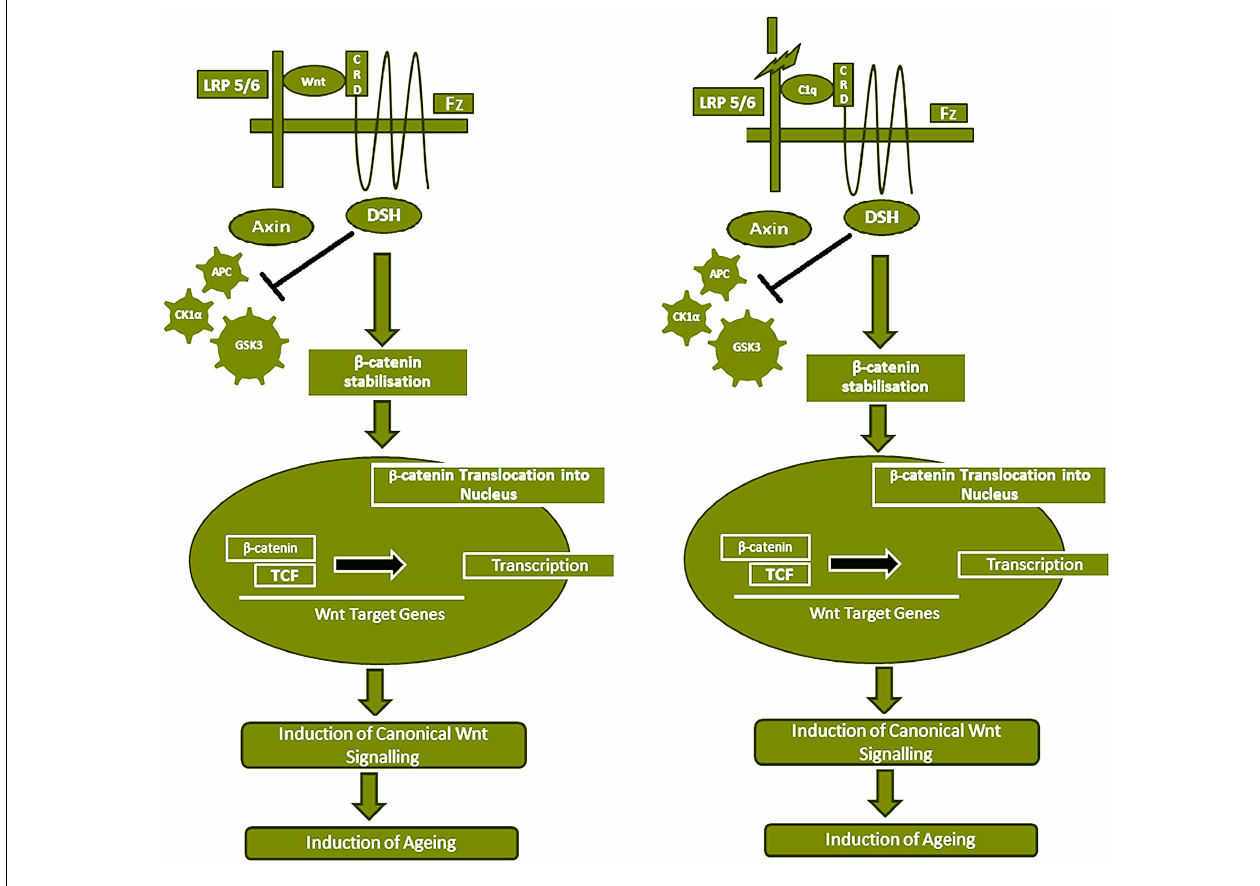
activated, which has been shown to induce aging. C1q concentration in the serum increases with age. C1q competes with 200-fold higher binding affinity with Wnt for Fz receptor and stimulates C1s-dependent cleavage of the ectodomain of LRP6. The C1q binding to Fz receptor also blocks the β -catenin destruction complex (APC, PP2A, GSK3, and CK1 α ) and results in stabilization of β -catenin in the cytoplasm, which is then translocated into the nucleus. Subsequently, canonical Wnt signaling is